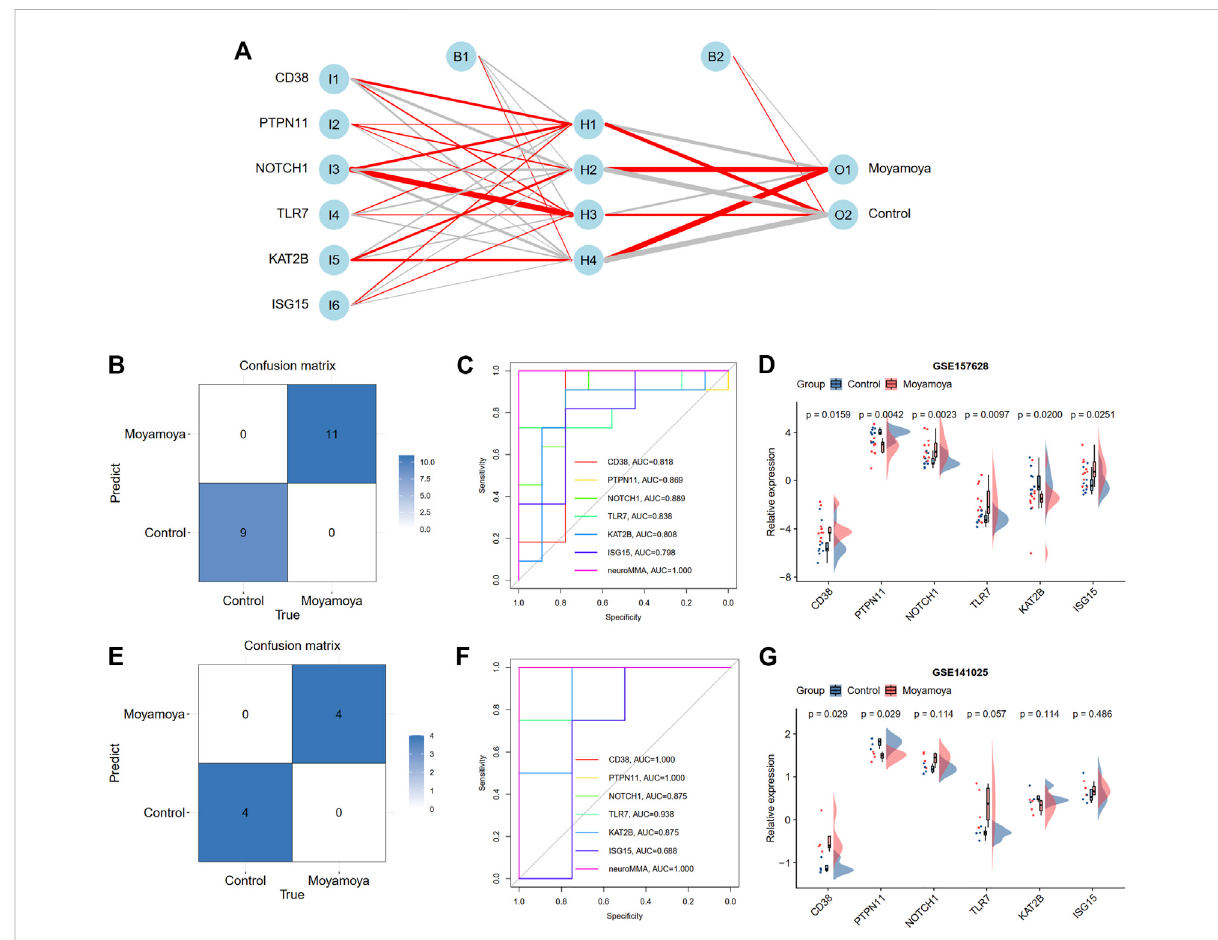
FIGURE 8 Construction and validation a BP neural network diagnostic model. (A) Results of neural network visualization. The positive weights are connected with red lines, and the negative weights are connected with gray lines. The thickness of the lines re fl ects the value of the weights. (B) A confusionmatrixshows theclassi fi cationability ofneuralnetwork intrainingdataset. (C) ROCcurveshowsthediagnosticabilityofneuralnetworkin training dataset. (D) The expression levels of six hub DEARGs in training dataset. (E) A confusion matrix shows the classi fi cation ability of neural network in test dataset. (F) ROC curve shows the diagnostic ability of neural network in test dataset. (G) The expression levels of six hub DEARGs in test